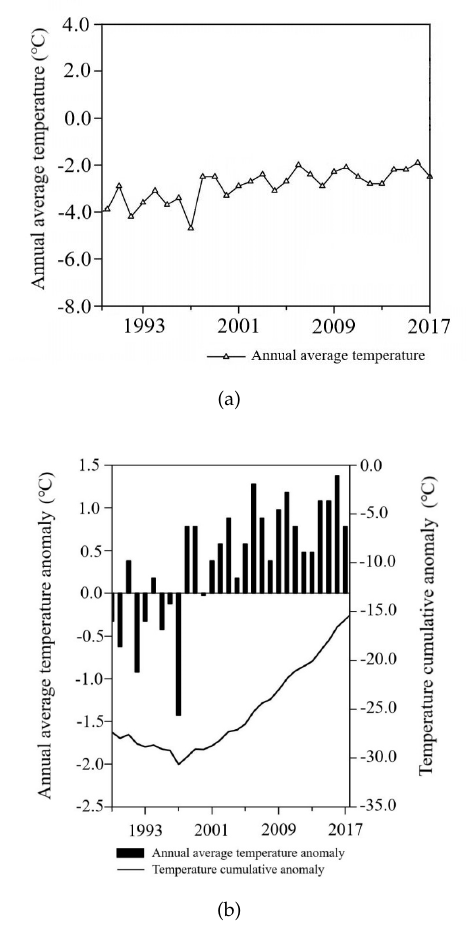
Figure 16. ( a ) Annual mean temperature at Maduo station in the source region of the Yellow River; and ( b ) annual average temperature anomalies at Maduo station during the period 1990–2017